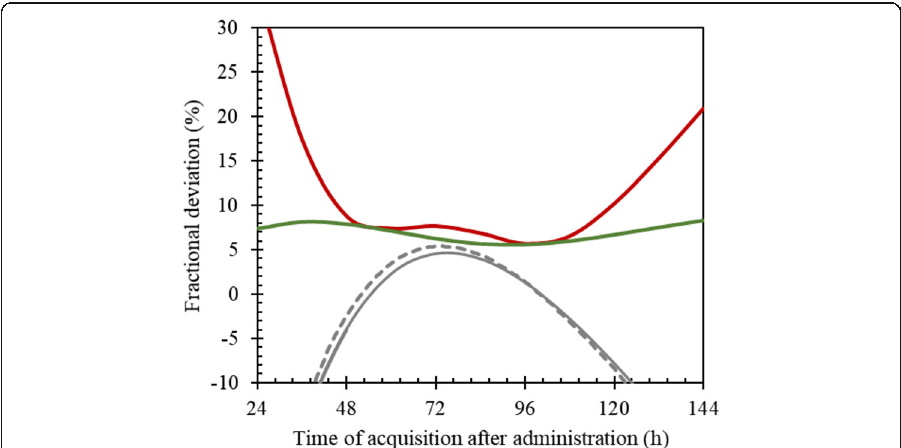
Fig. 4 Fractional deviation between the actually delivered AD and the AD calculated using method G, as function of the time of acquisition for the single image ( t ref in Eq. 8). The dashed line shows the theoretical fractional deviation ( E 1 ), following Eqs. 9 and 10. Solid lines show deviations obtained for the patient data, determined as the mean value of E 2 (grey), the SD around the mean E 2 (green) and the root-mean square deviation in E 2